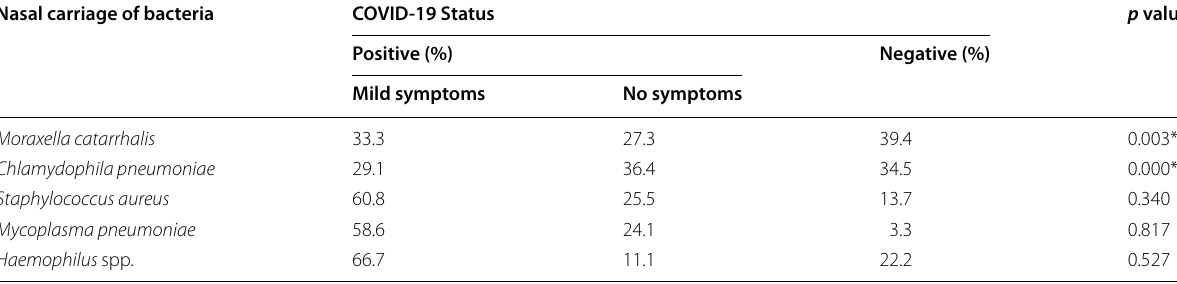
Haemophilus spp *Significant at 5% level